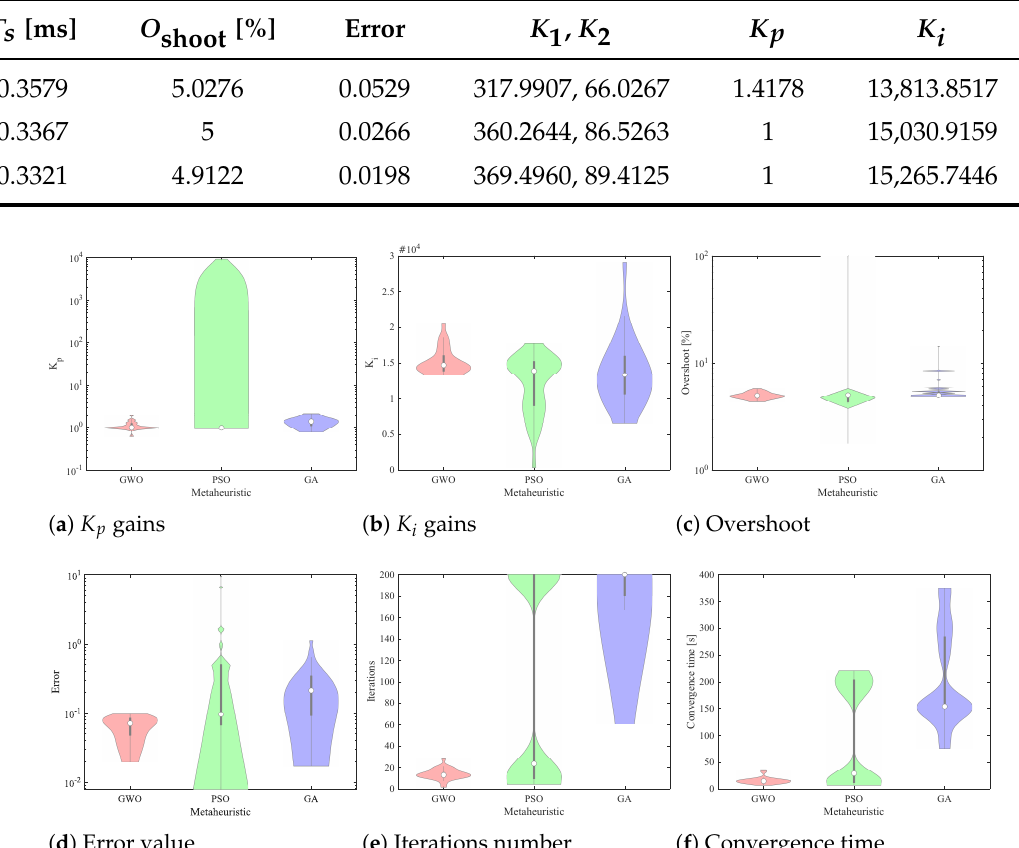
Table 7. Comparative data for the best MG controllers tuned with three different metaheuristics. The error is calculated with (42).